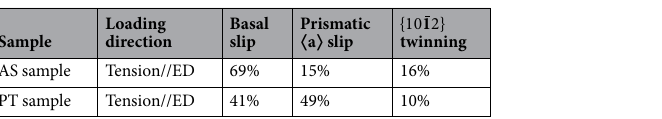
Table 2. The fractions of grains favoring basal slip, prismatic slip, and {1012} twinning during tension along the ED. The used CRSS ratio of basal slip: {1012} twinning: prismatic slip is